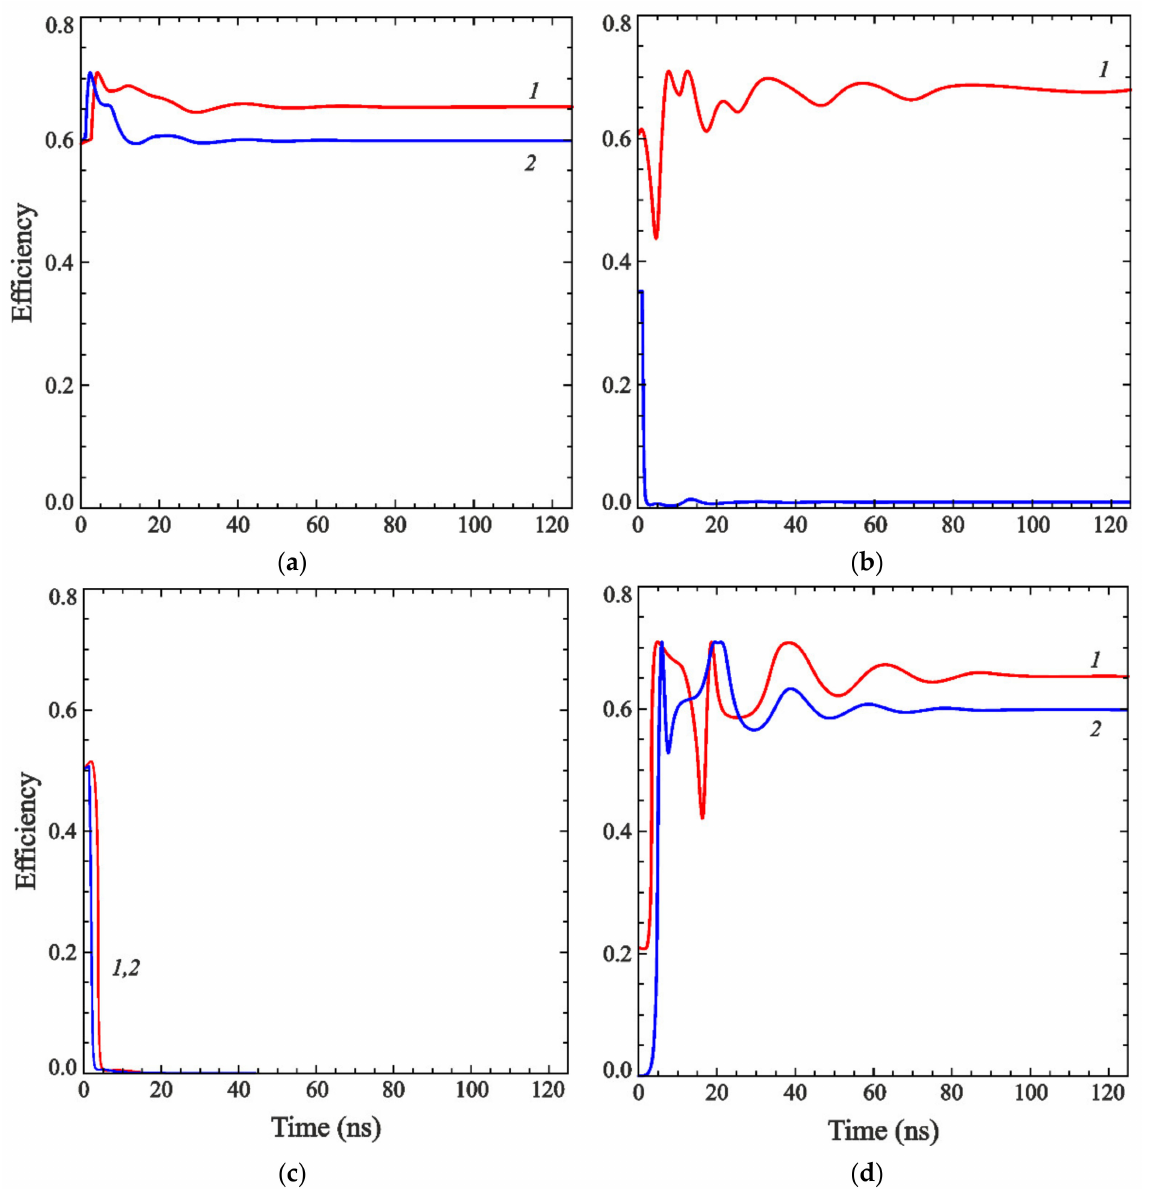
Figure 6. Time histories of efficiencies of the first and second gyrotron illustrating different regimes at I 0 = 0.05, µ = 15.0, ∆ H = 0.534, ρ = 0.5, ψ = 1.0 π , τ d = 3.0: ( a ) peer-to-peer locking; ( b ) suppression of one gyrotron by another; ( c ) oscillation death; ( d ) excitation of one gyrotron by